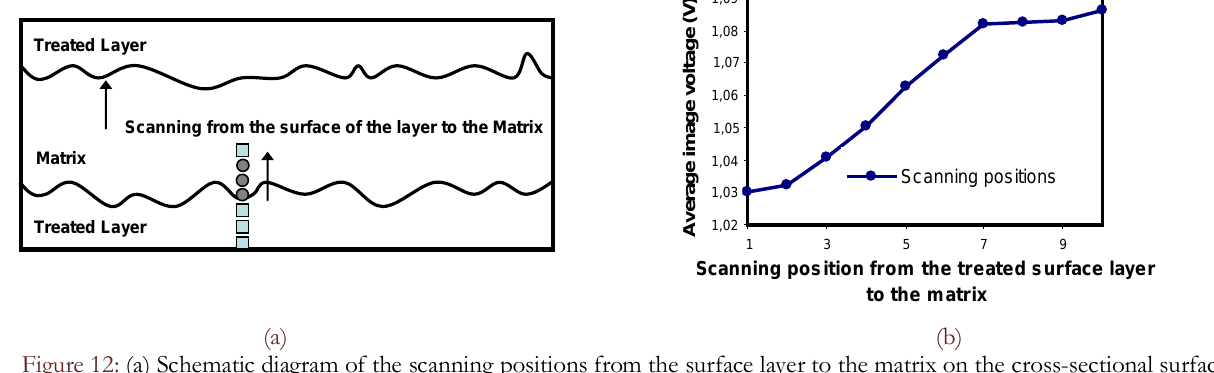
Figure 12: (a) Schematic diagram of the scanning positions from the surface layer to the matrix on the cross-sectional surface. (b)Variation in average image voltage while scanning from the treated surface layer to the matrix as indicated in (a)